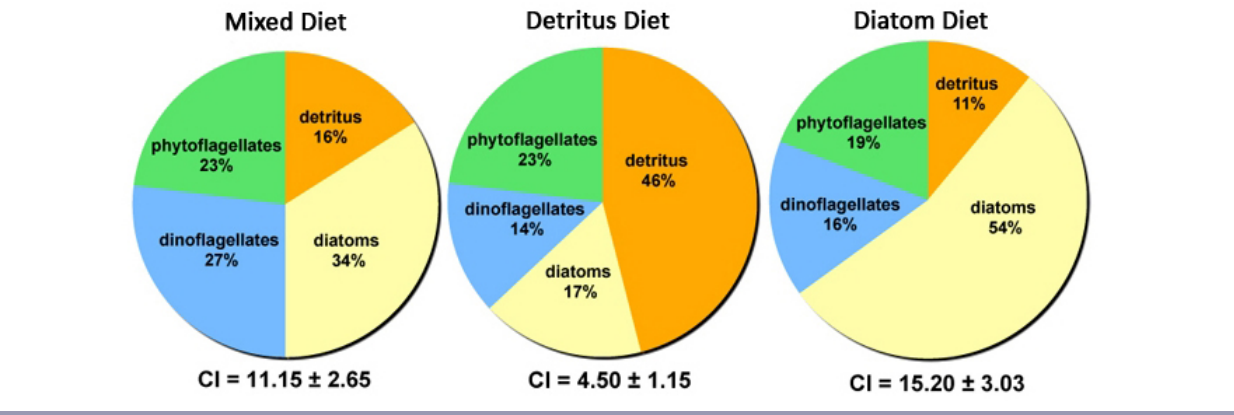
Fig. 6 . Mussel diet scenarios: composition of the three simulated diets by considering the main phytoplankton groups and detritus. For each scenario the CI was calculated and reported below the circles. Values are averages for three years of simulation (2002-2004).